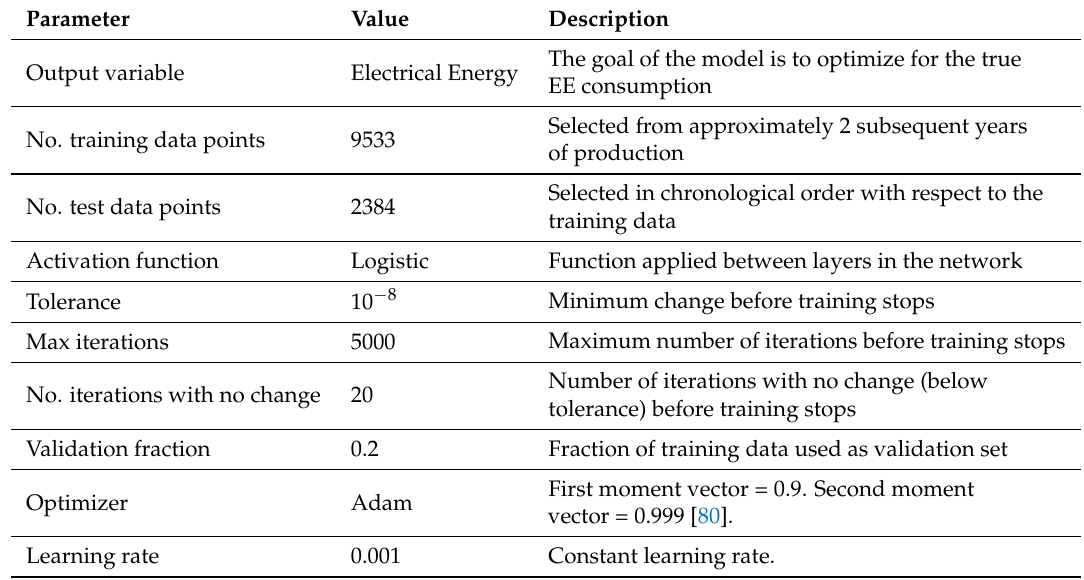
Table A2. Parameters that were not varied in the grid-search. Specifications can be seen in the Scikit-learn package MLPRegressor that was used to create the models. See Table A3 for the software used to create the